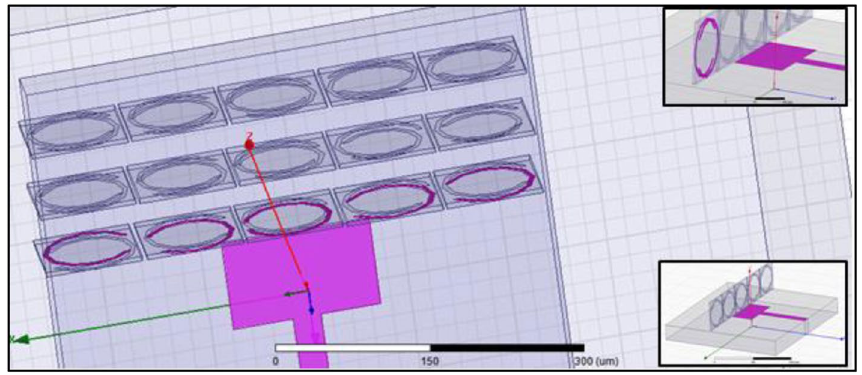
Fig. 8 DBC-SRR loaded vertically microstrip patch